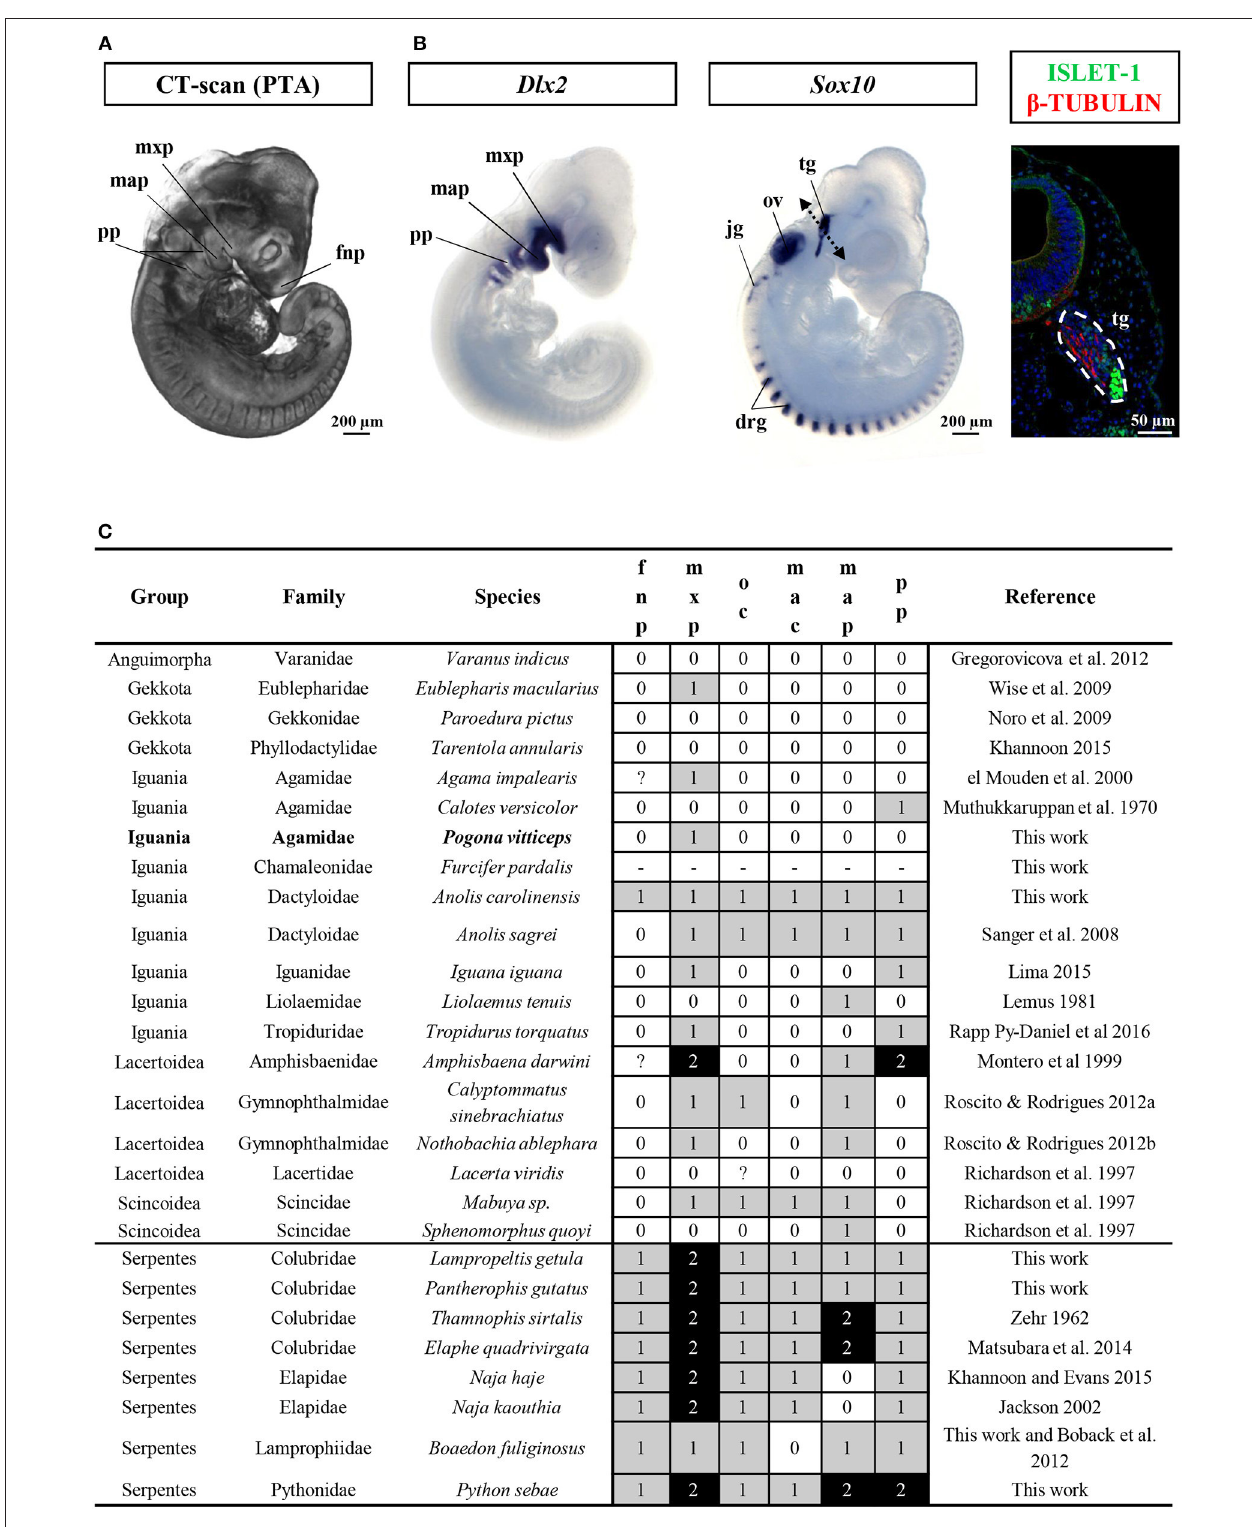
FIGURE 2 | Characterization of craniofacial primordia in squamates. (A) Volume rendering image of Pogona vitticeps embryo stained with phosphotungstic acid (PTA) at the oviposition stage (0 dpo). (B) Whole-mount in situ hybridization with cranial neural crest cell markers ( Dlx2 , left panel; Sox10, middle panel) or immunohistochemistry with neuronal markers (Islet-1 and β -tubulin, right panel) in Pogona vitticeps embryo at 0 dpo. The dashed double-headed arrow in the middle